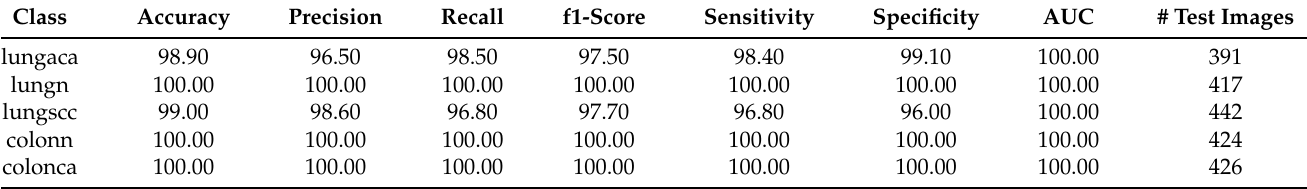
Table 3. Precision, Recall, f1-score, Accuracy and the number of test images per class, Note: Results are given in percentage.